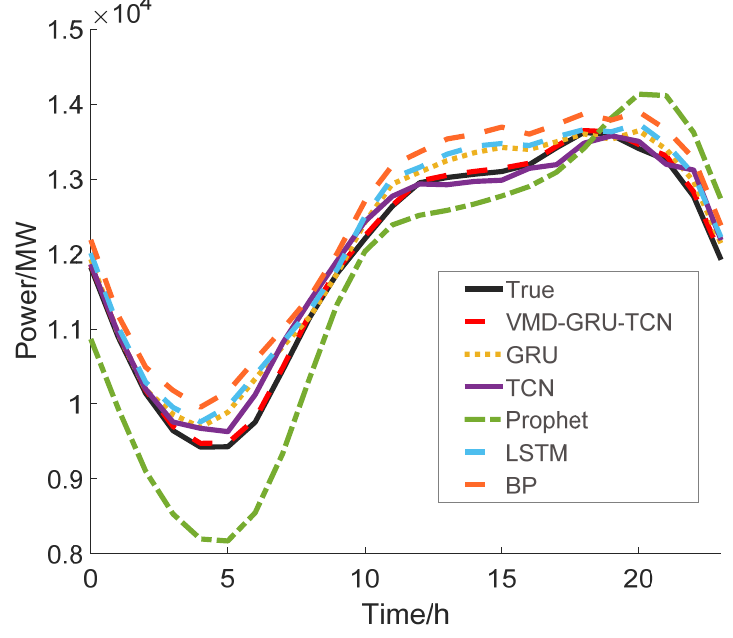
Figure 11. The forecasting result of data set 1.